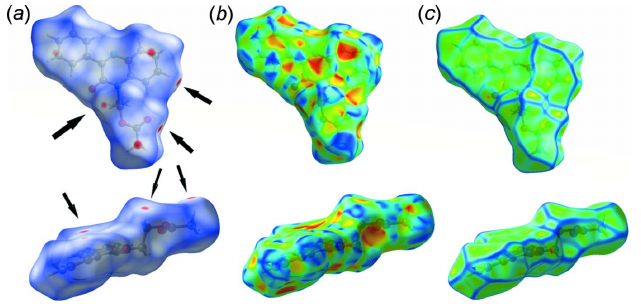
Figure 3 Front (top) and side (bottom) views of the Hirshfeld surface plotted over ( a ) d norm , ( b ) shape-index and ( c ) curvature.